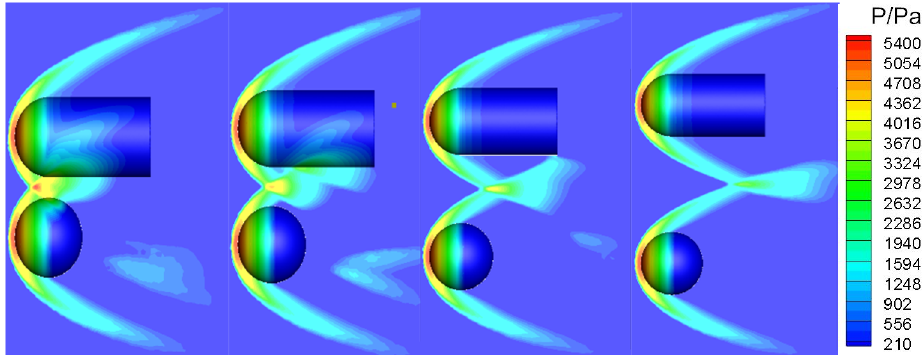
Figure 8. Pressure contours of flows around sphere and spherocylinder placed and paralleled with